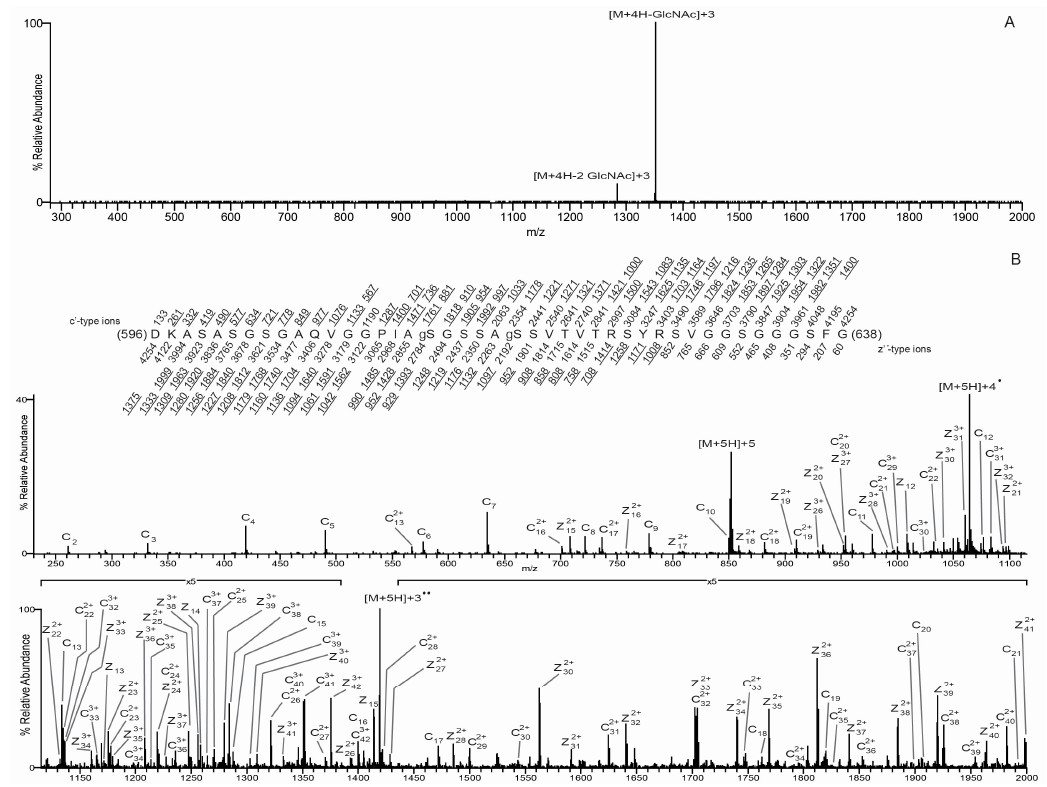
Figure 5. O -GlcNAc site mapping on the S612A/T643A-mutated mature lamin A tail via liquid chromatography-MS/MS. ( A ) CAD MS/MS spectrum recorded on the (M + 4H) 4+ ions ( m / z 1064.2561) of the di-GlcNAcylated peptide DKASASGSGAQVGGPIAgSGSSAgSSVTVTRSYRSVGGSGGGFG.